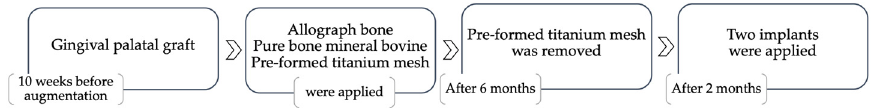
Figure 3. The surgical treatment plan